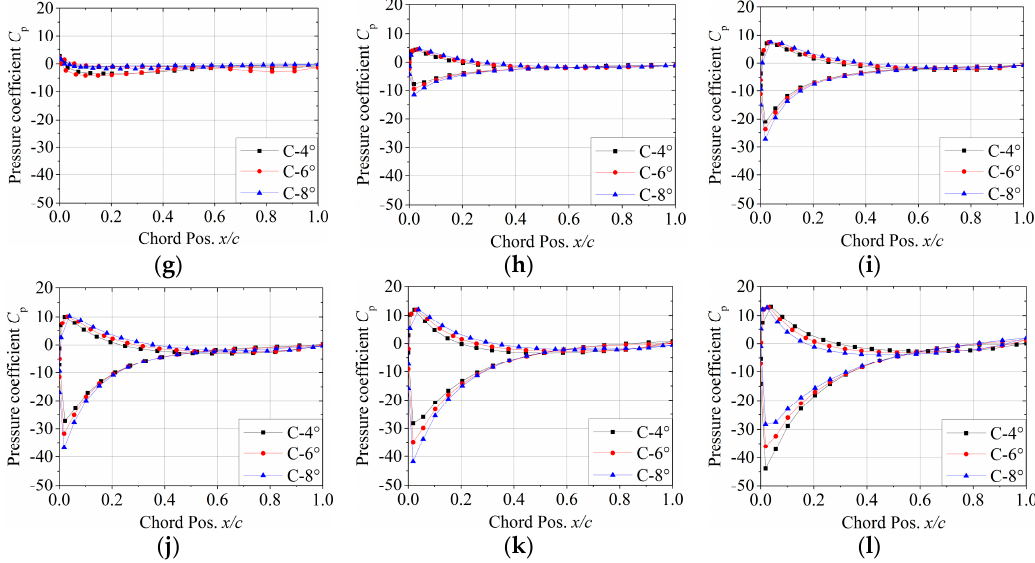
Figure 12. Pressure distribution acting on blade surface at different azimuth angles of 0 ◦ ≤ θ ≤ 360 ◦ and at different blade pitch angles of β = 4 ◦ , 6 ◦ and 8 ◦ , respectively. ( a ) Azimuth angle θ = 0 ◦ ; ( b ) Azimuth angle θ = 30 ◦ ; ( c ) Azimuth angle θ = 60 ◦ ; ( d ) Azimuth angle θ = 90 ◦ ; ( e ) Azimuth angle θ = 120 ◦ ; ( f ) Azimuth angle θ = 150 ◦ ; ( g ) Azimuth angle θ = 180 ◦ ; ( h ) Azimuth angle θ = 210 ◦ ; ( i ) Azimuth angle θ = 240 ◦ ; ( j ) Azimuth angle θ = 270 ◦ ; ( k ) Azimuth angle θ = 300 ◦ ; ( l ) Azimuth angle θ = 330 ◦